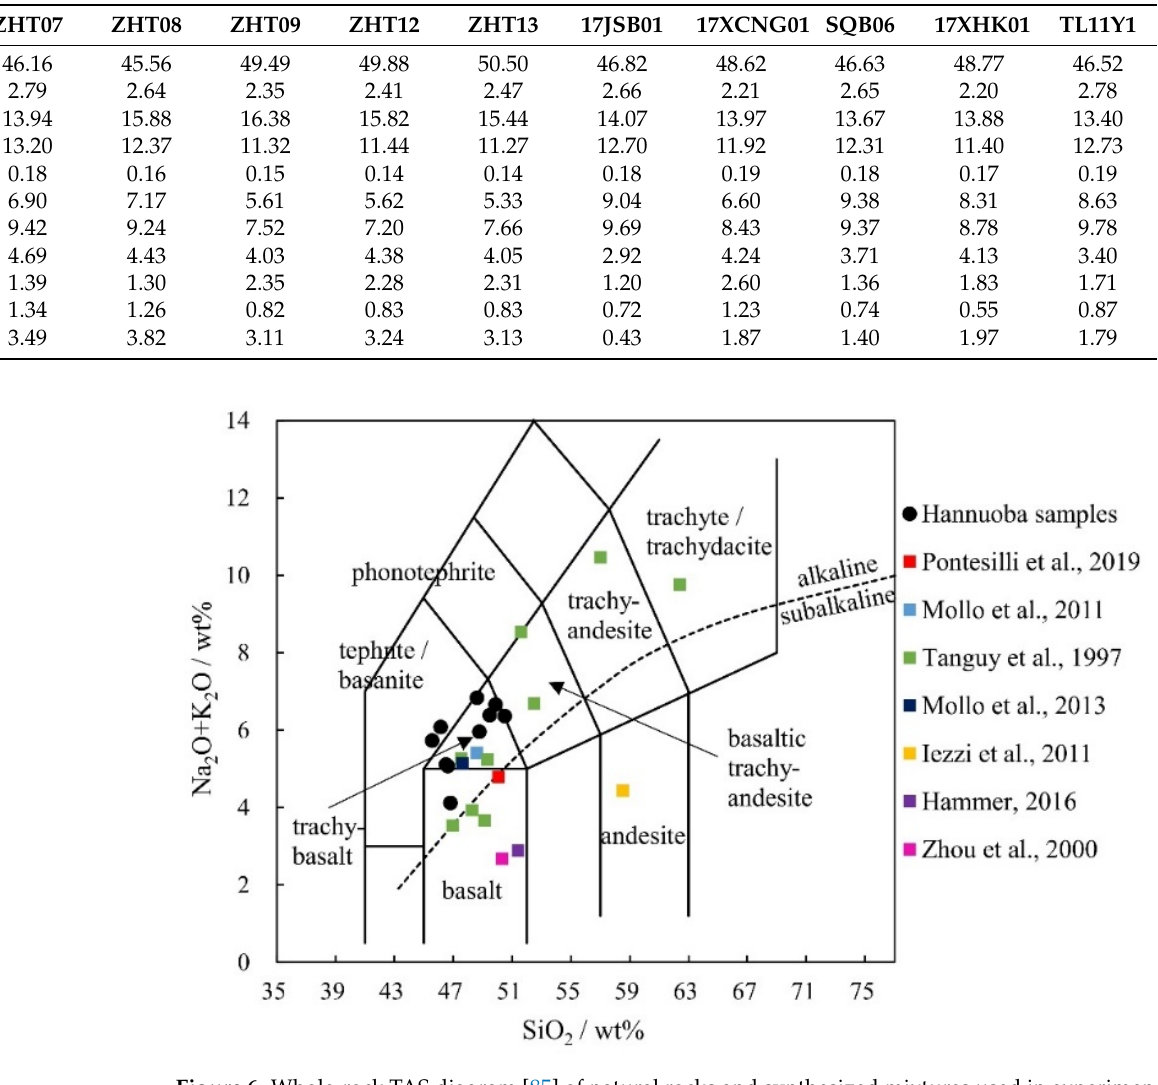
Figure 6. Whole-rock TAS diagram [85] of natural rocks and synthesized mixtures used in experimental petrology. The alkaline line is cited by Miyashiro [86]. Other samples come from nature [5,7,87] and synthetic materials in experimental petrology [4,6,34,42].